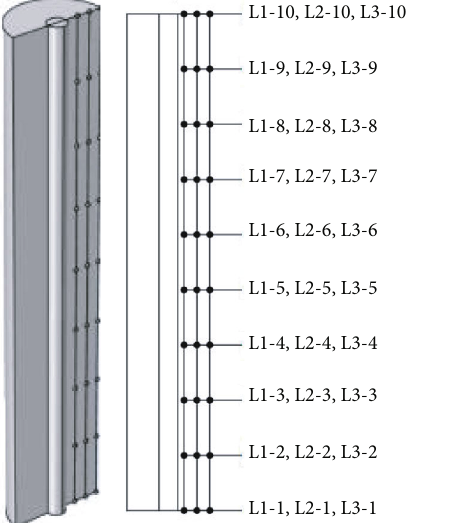
Figure 5: Schematic diagram of thermocouple arrangement.